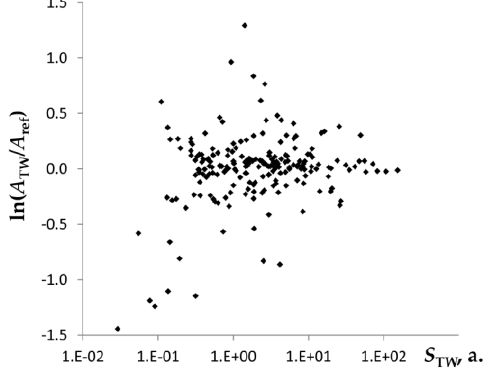
Figure 6. Comparison of transition probabilities calculated in this work ( A TW ) with reference values ( A ref , see text). Natural logarithm of the ratio A TW / A ref is plotted against our calculated line strength, S TW (in atomic units).